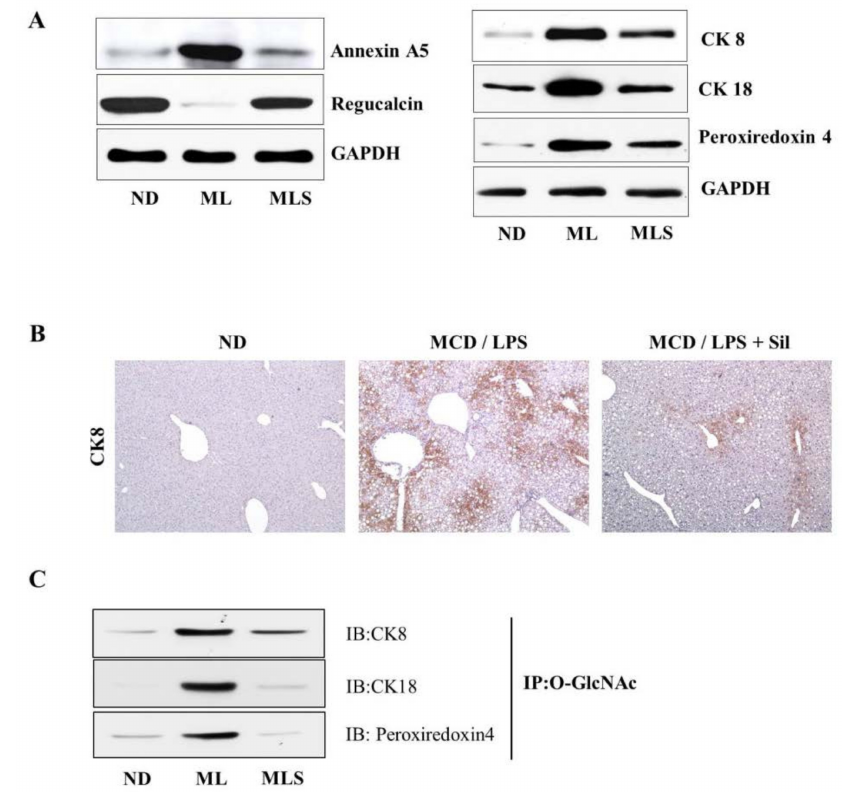
Figure 2. Validation of the differentially expressed protein. Liver tissue extracts were prepared from the mice fed ND, MCD/LPS, or MCD/LPS + silibinin. ( A ) The left panel shows the hepatic expression levels of annexin A5 and regucalcin, as determined by immunoblotting using equivalent amounts of total liver protein. The expression levels were normalized relative to GAPDH. The right panel shows the relative expression levels of CK8, CK18, and PRX4. Data represent three independent experiments. ( B ) Liver sections were subjected to immunohistochemical analysis using antibodies to CK8. × 100 magnification. ( C ) O -GlcNAc was immunoprecipitated with anti- O -GlcNAc antibody, and then immunoblotted against CK8, CK18, or peroxiredoxin-4,